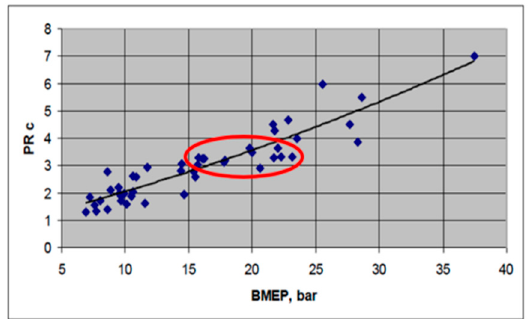
Figure 2. Break Mean Effective Pressure ( BMEP) and compressor pressure ratio correlation [19].